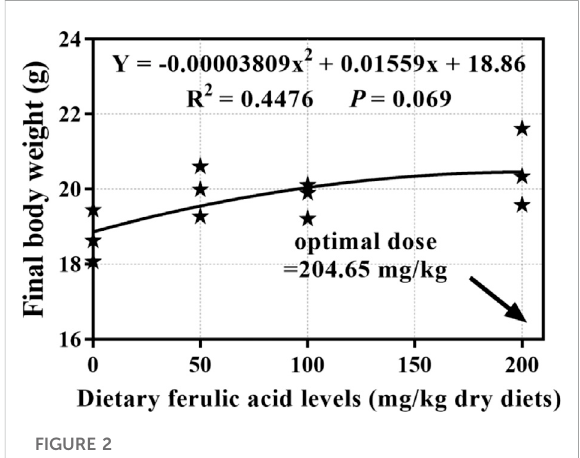
FIGURE 2 Quadratic regression analysis of dietary ferulic acid levels versus fi nal body weight in juvenile grass